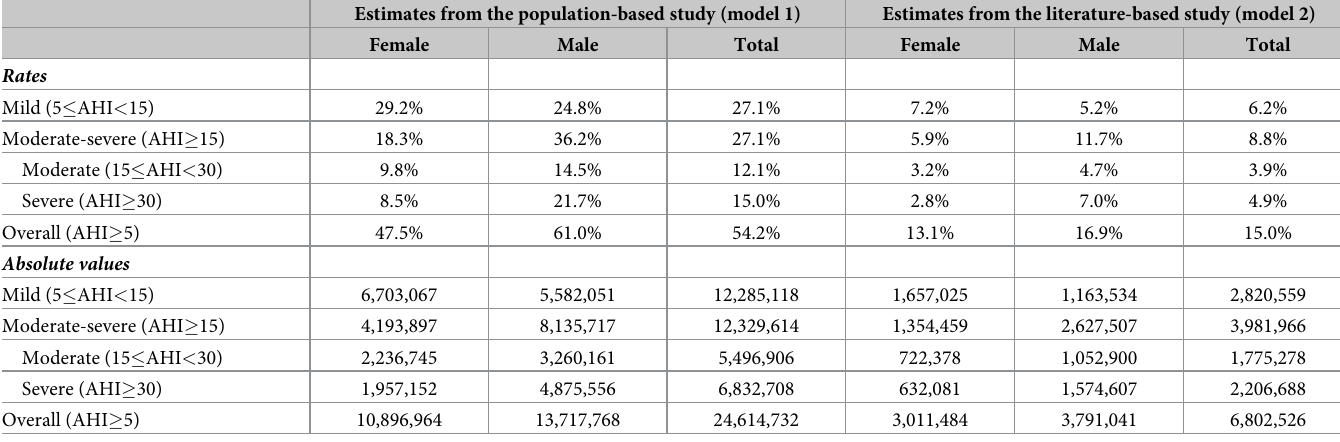
Table 1. Prevalence of OSA for the general adult population in Italy (aged 15–74). Estimates from the population-based study (model